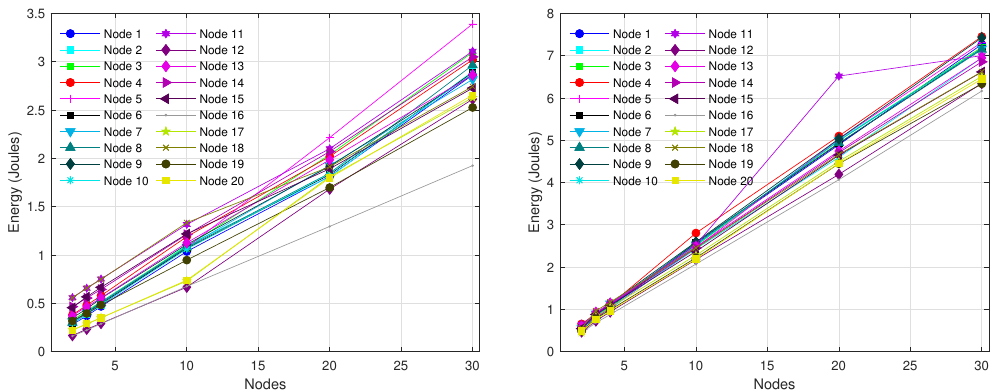
Figure 13. Energy consumption after the simulation of the 20-node topology, with DC = 3% ( left ) and DC = 10% ( right ), for 2, 3, 4, 10, 20 and 30 rounds.